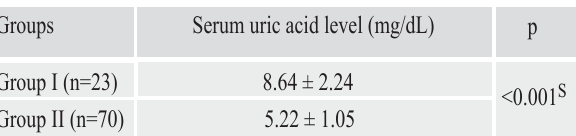
Table I: Comparison of serum uric acid levels between two groups (N=93) Groups